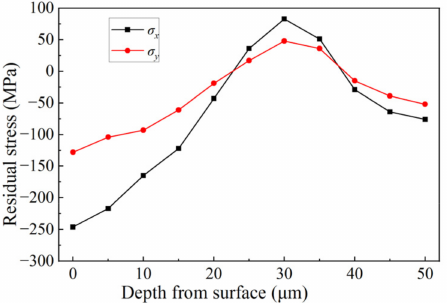
Figure 11. Distribution of residual stress in silicon nitride ceramic along depth